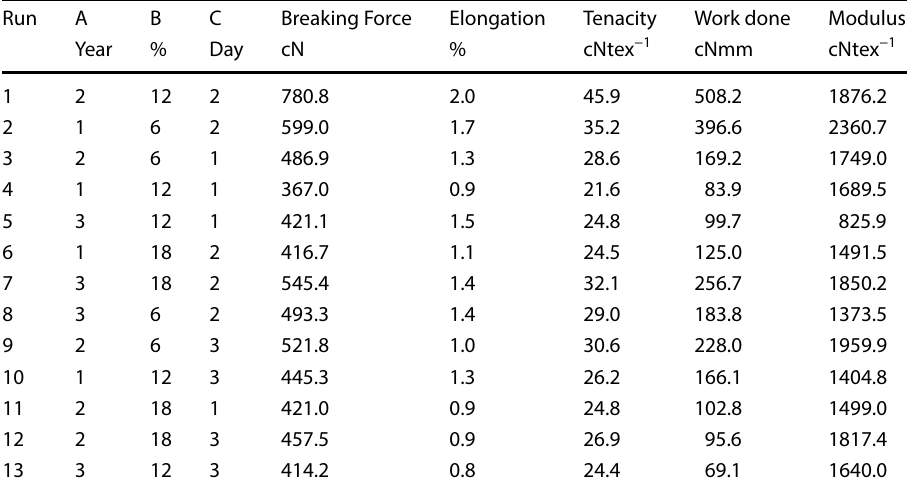
Table 11 Predicted values of responses (breaking force, elongation tenacity, work done, and modulus)